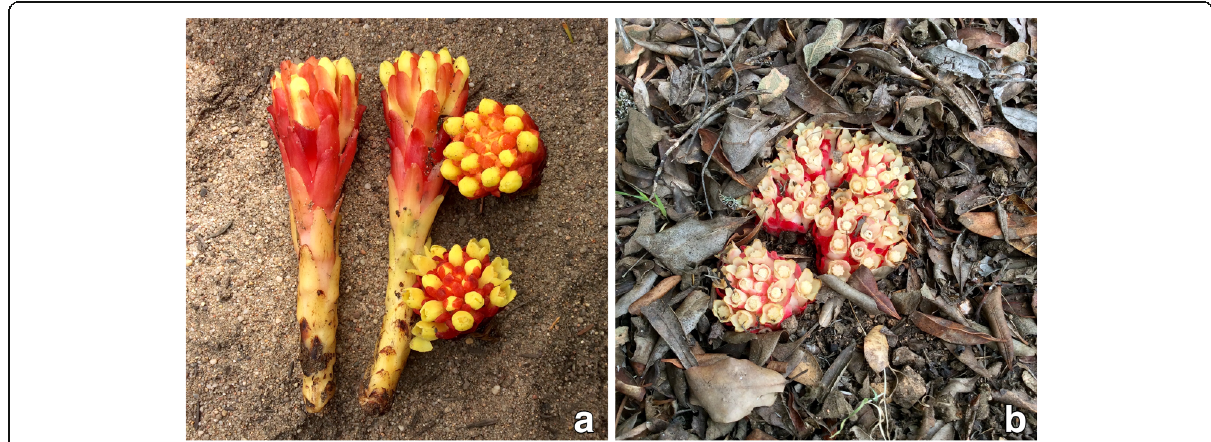
Fig. 2 a Cytinus hypocistis inflorescences, Sardinia; ( b ) Cytinus ruber inflorescences,